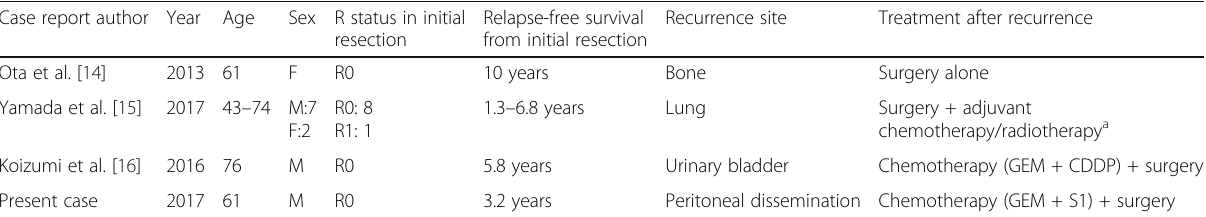
Table 1 The cases for which resection was performed for recurrence of hilar